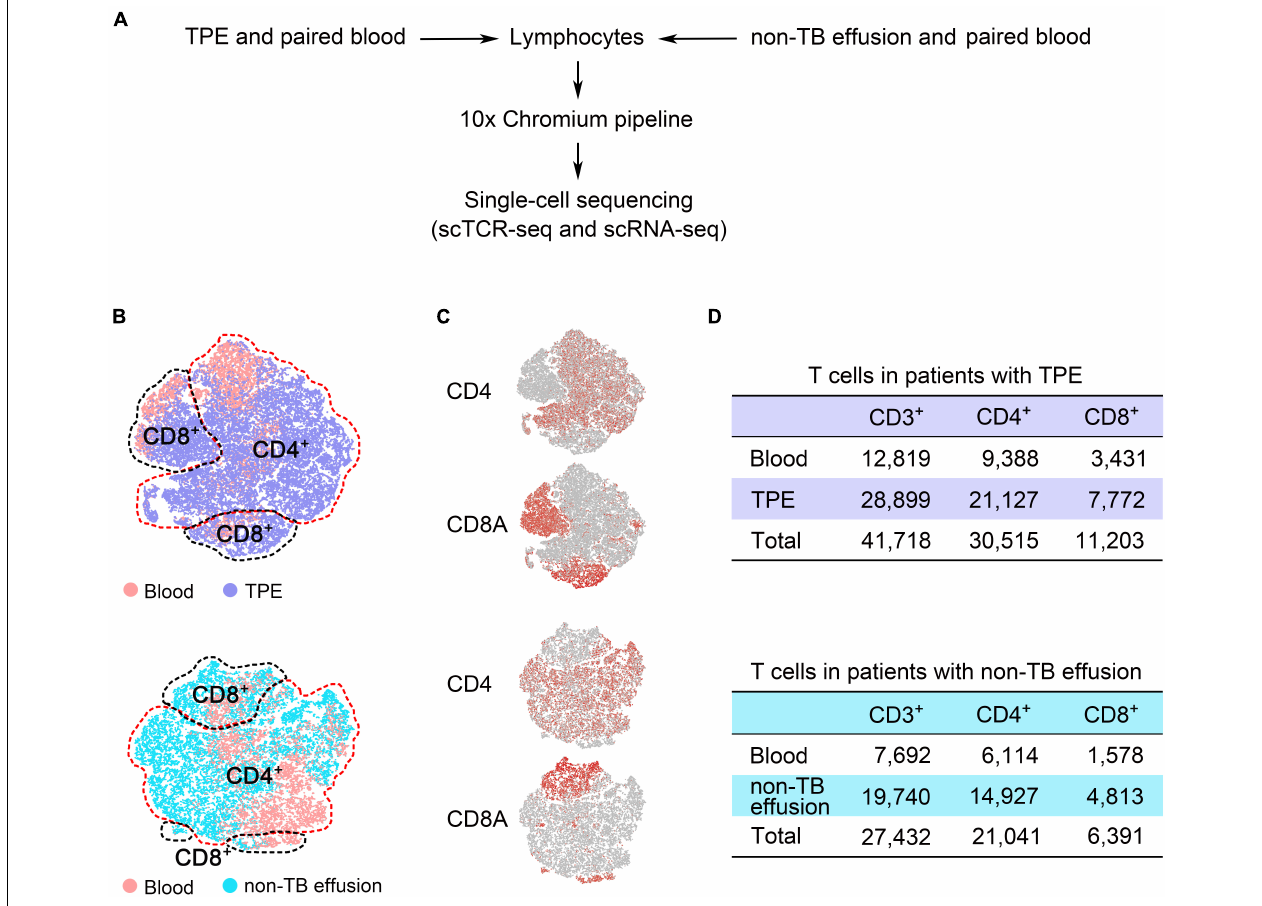
FIGURE 1 | Defining T cell subsets with both unique paired productive TCR αβ sequences and transcriptional profiles from pleural effusion and blood from patients with TPE and those with non-TB effusion. (A) Overview of the experimental design. (B) t-SNE plots of T cell subsets from TPE patients and non-TB effusion patients (each n = 5), with each color-coded for sample type. (C) Plots showing the expression of gene markers for CD4 + and CD8 + T cells defined in panel (B) . (D) After combining sc-RNA seq and sc-TCR seq data, 41,718 CD3 + T cells and 27,432 CD3 + T cells were identified in TPE patients and non-TB effusion patients, respectively. TPE, tuberculous pleural effusion; non-TB,